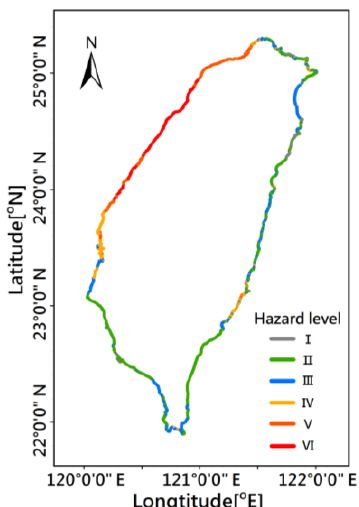
Figure 11. A comprehensive potential highest storm tide (HST) hazard map.